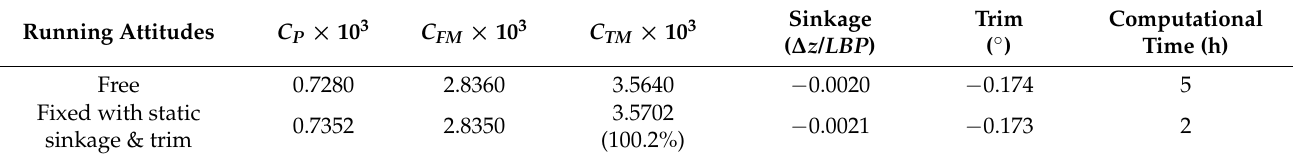
Table 5. CFD validation with respect to running attitude conditions for the optimal